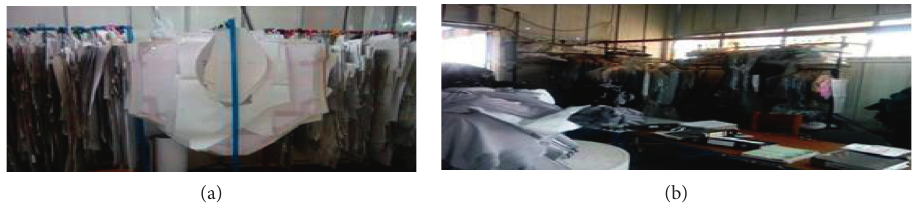
Figure 7: Sample making and designing room (photo taken from company A).